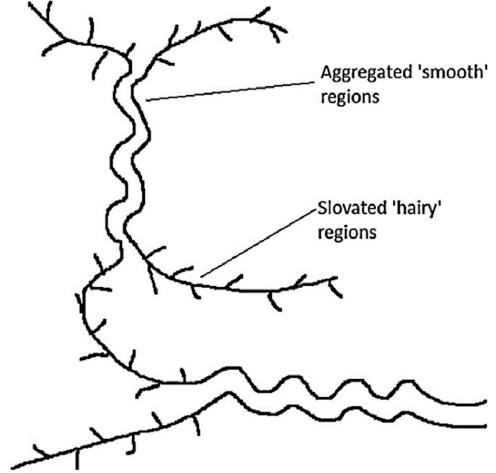
Figure 2. Entanglement of galactomannan polymers; the smooth regions form the insoluble part of the gel while the hairy regions permit the solubility of the polysaccharide [12].